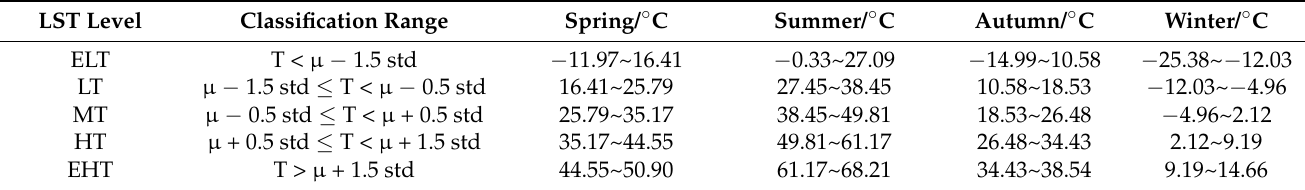
Table 1. LST classification level